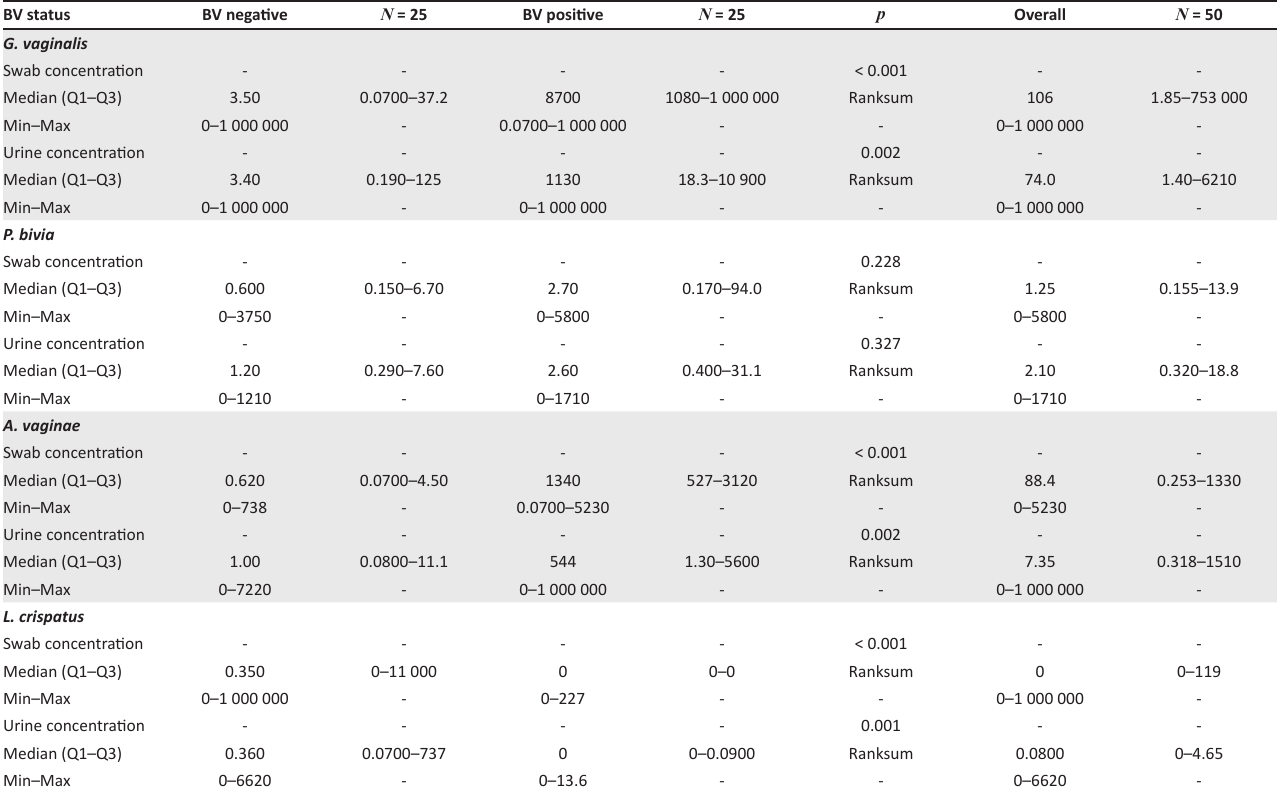
TABLE 2-A1: Median values for the abundance of bacterial vaginosis-associated microorganisms across the bacterial vaginosis (BV) states. BV status